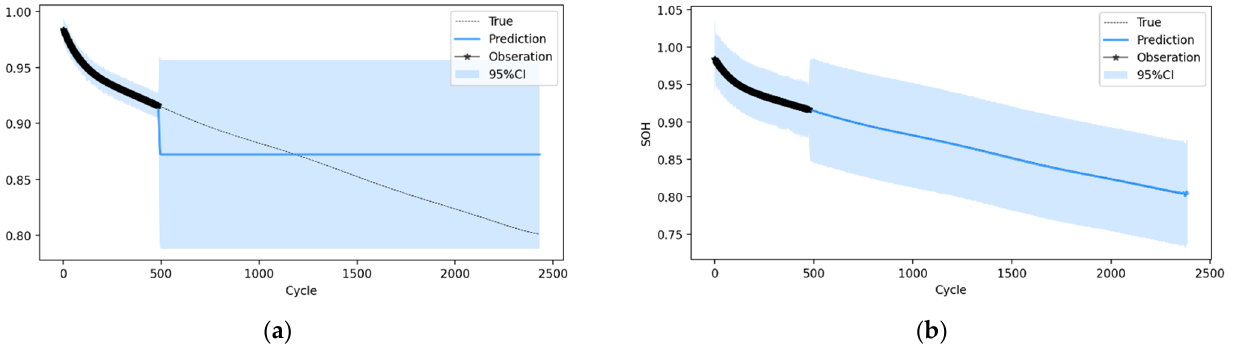
Figure 3. SOH prediction results for battery cell (35 °C_0.5C0.5C): ( a ) SOH prediction result based on the SOGPR; ( b ) SOH prediction result based on the MOGPR.